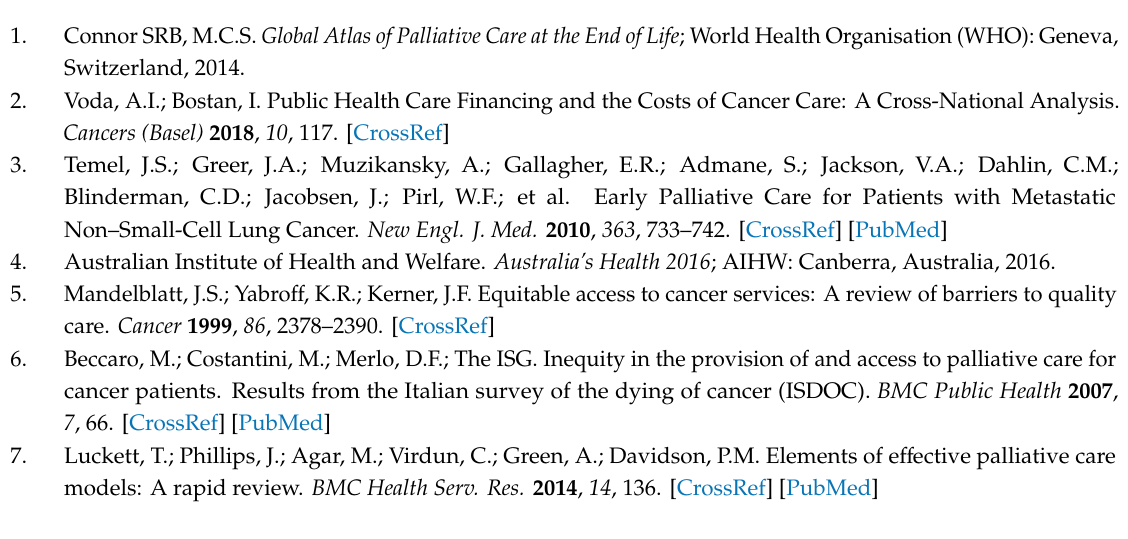
Table S1: Electronic search strategy, Table S2: Eligibility criteria, Table S3: NHLBI Quality Assessment Summary of Results, Table S4: Characteristics summary of included studies, Table S5: Summary of geographical urban-rural measures and influence on end-of-life cancer care health service use